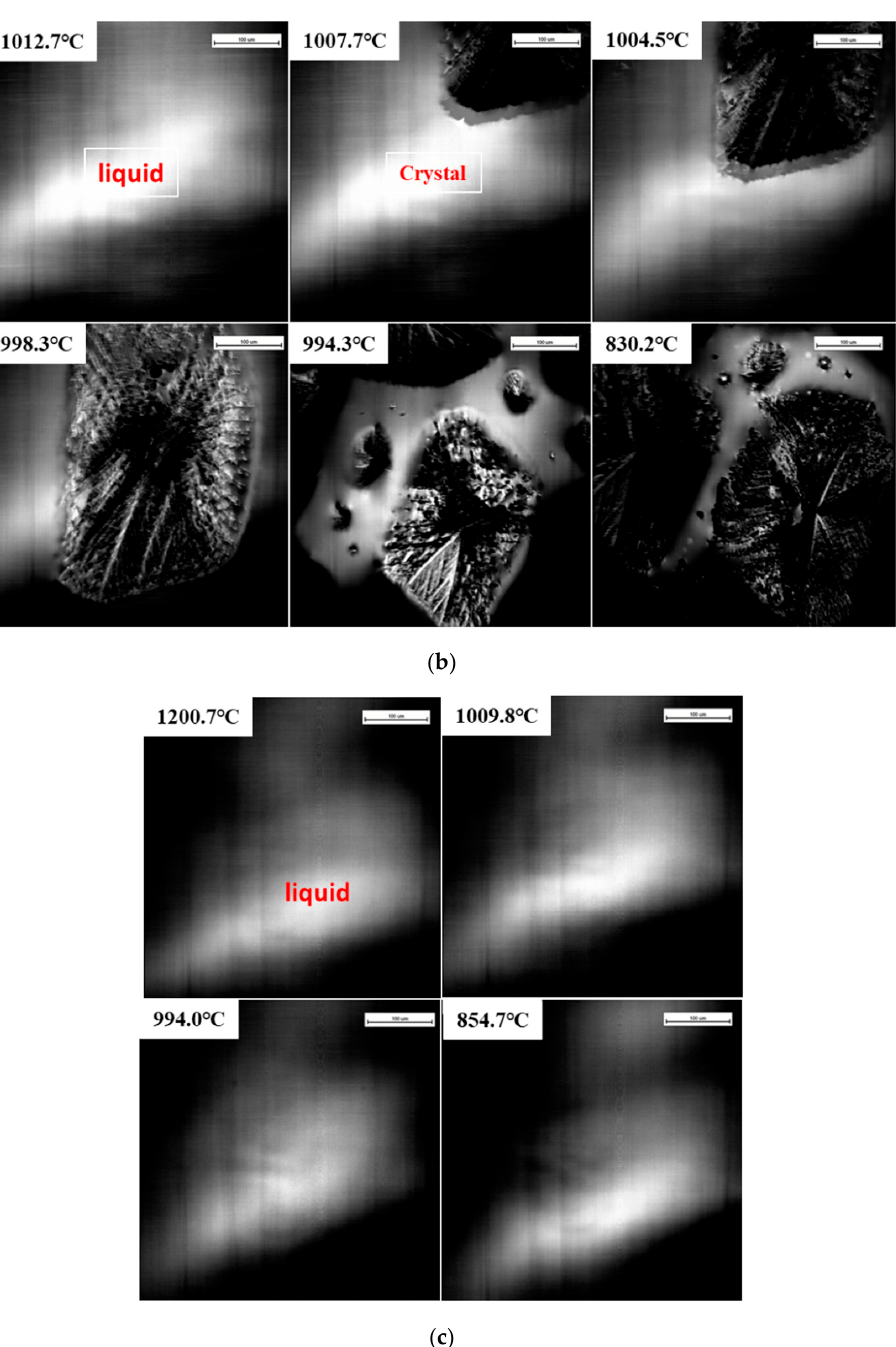
Figure 6. The crystallization process of the CaO–SiO 2 –CaF 2 -based mold flux measured by confocal scanning laser microscopy (CSLM) at different cooling rates: ( a ) 100 °C·min − 1 , ( b ) 150 °C·min − 1 , and ( c ) 200 °C·min − 1 .